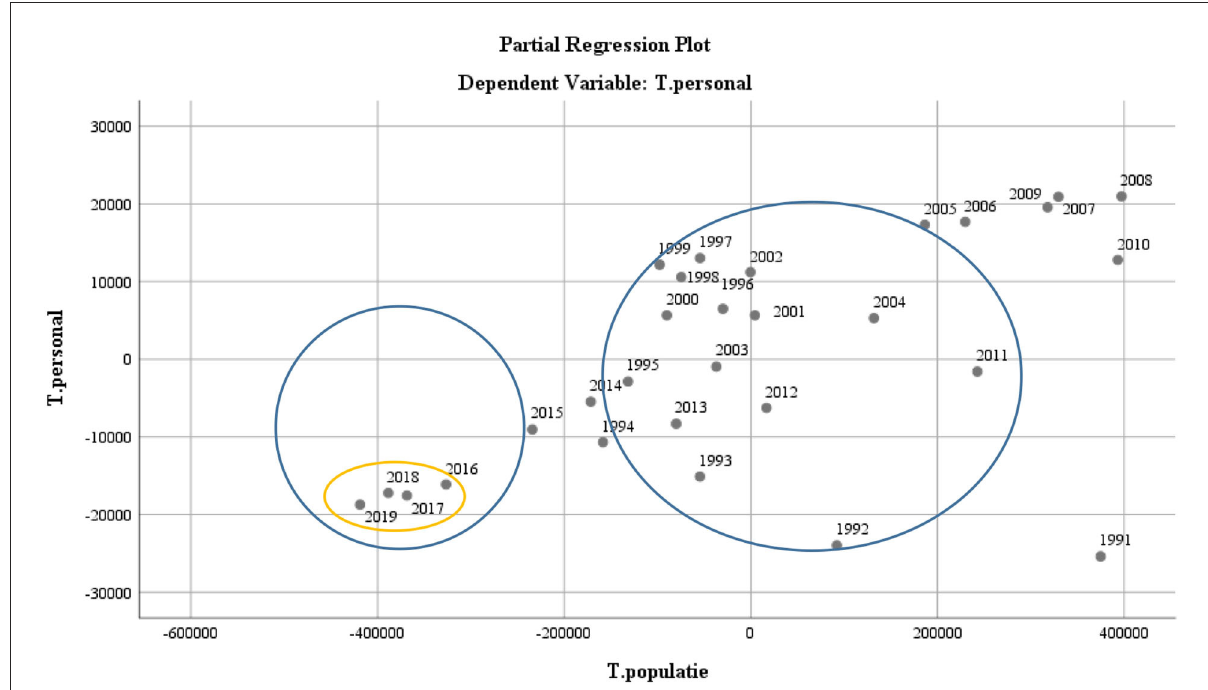
FIGURE6 Scatter diagram—to represent the dynamics of the staff in the Romanian educational system with the dynamics of the school population.